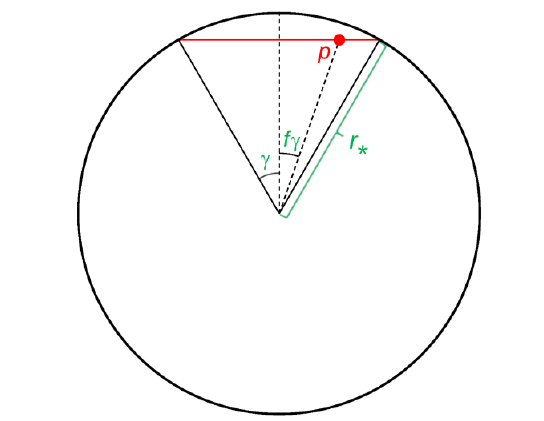
Figure 1 . A local operator at p , represented by the dot, is on the HRT surface anchored to the boundary of a spherical cap region, 0 (cid:20) (cid:20) (cid:13) , on the leaf at time (cid:17) (cid:3) , located at r = r (cid:3) . Note that the (cid:12)gure suppresses the time direction; for example, the operator is not at the same time as the